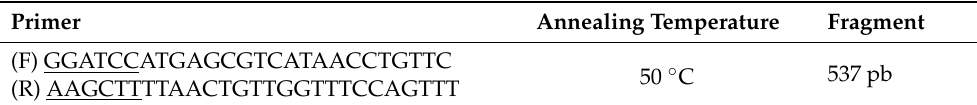
Table 2. pilS primers employed in this study, corresponding amplicon and annealing